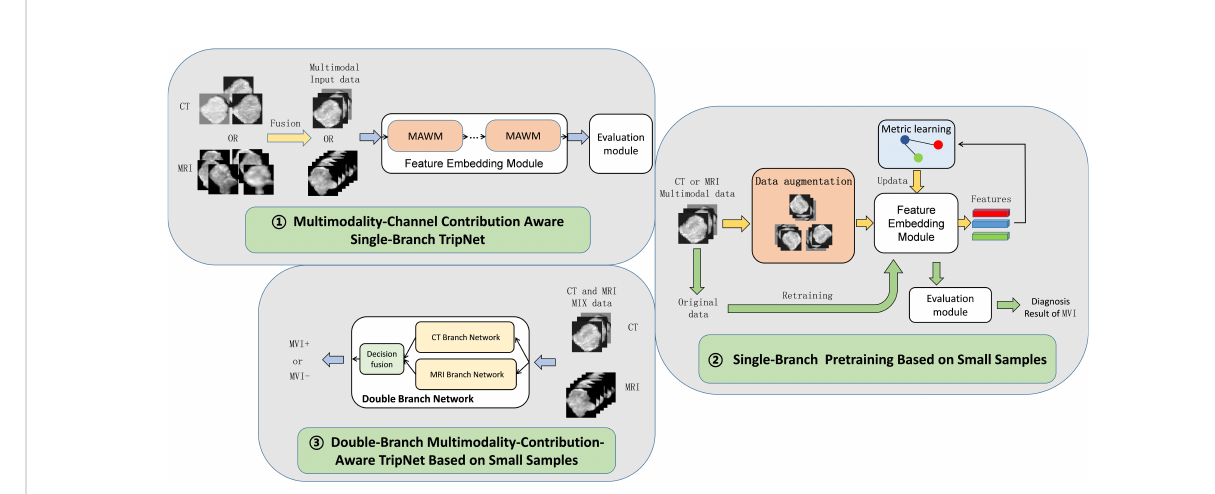
FIGURE 2 Flow chart of CT&MRI double-branch multimodality-contribution-aware TripNet. MAWM, multimodal channel adaptive weighted modules. The whole model consists of three steps. The fi rst step is to establish Multimodality-Channel Contribution Aware Single-Branch TripNet. The highlight of this step is to integrate the prior knowledge of radiologists by setting the multimodal channel adaptive weighted modules (MAWM). Considering the importance of different modal in clinical diagnosis, the network can adaptively increase important modal features, and the attention to the features of the unimportant modal channels can be reduced. In the second step, based on the fi rst step, a single-branch two- step training strategy is added for small sample problems, including data enhancement and metric learning, and then the CT branch network and MRI branch network are obtained. In the third part, the CT Branch and MRI Branch network are fused and updated with CT and MRI Mixed data, and double-branch Multimodality- contribution-aware TripNet is fi nally